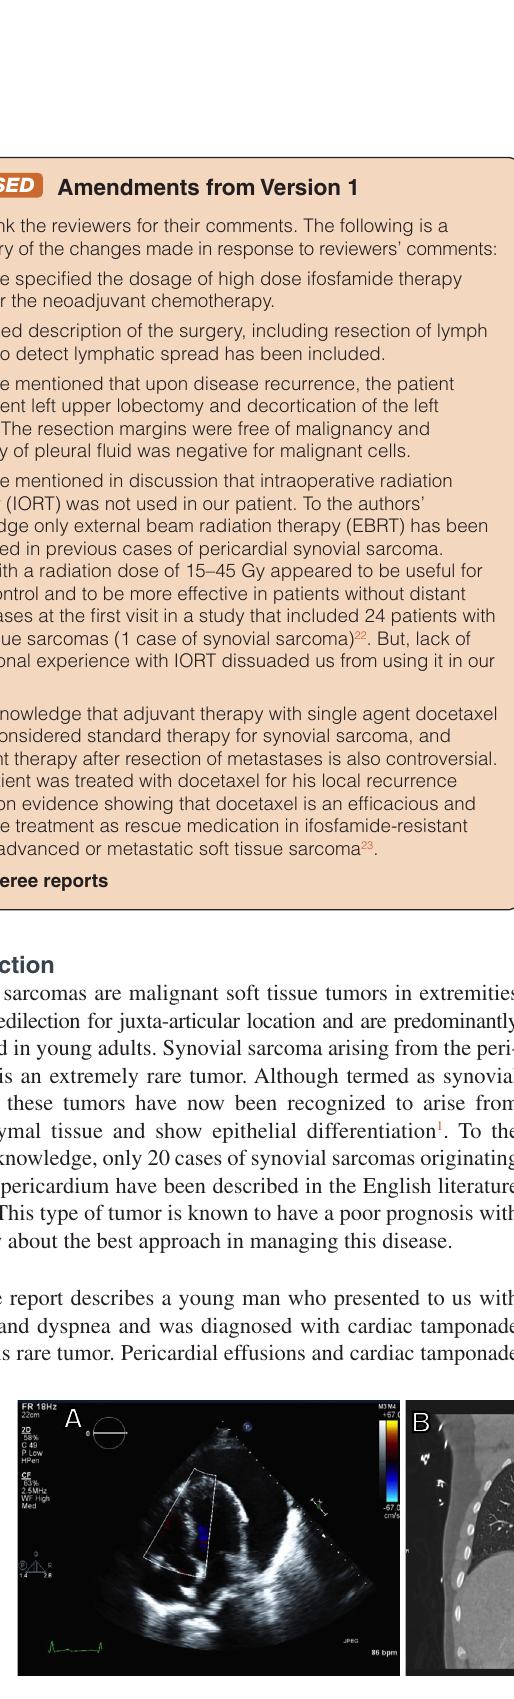
Figure 1. The transthoracic echocardiogram and CT chest findings. The echocardiogram image ( a ) shows large pericardial effusion with collapse of the free wall of right atrium. The coronal ( b ) and axial ( c ) CT images show the effusion and an enormous heterogeneous mass in the pericardial